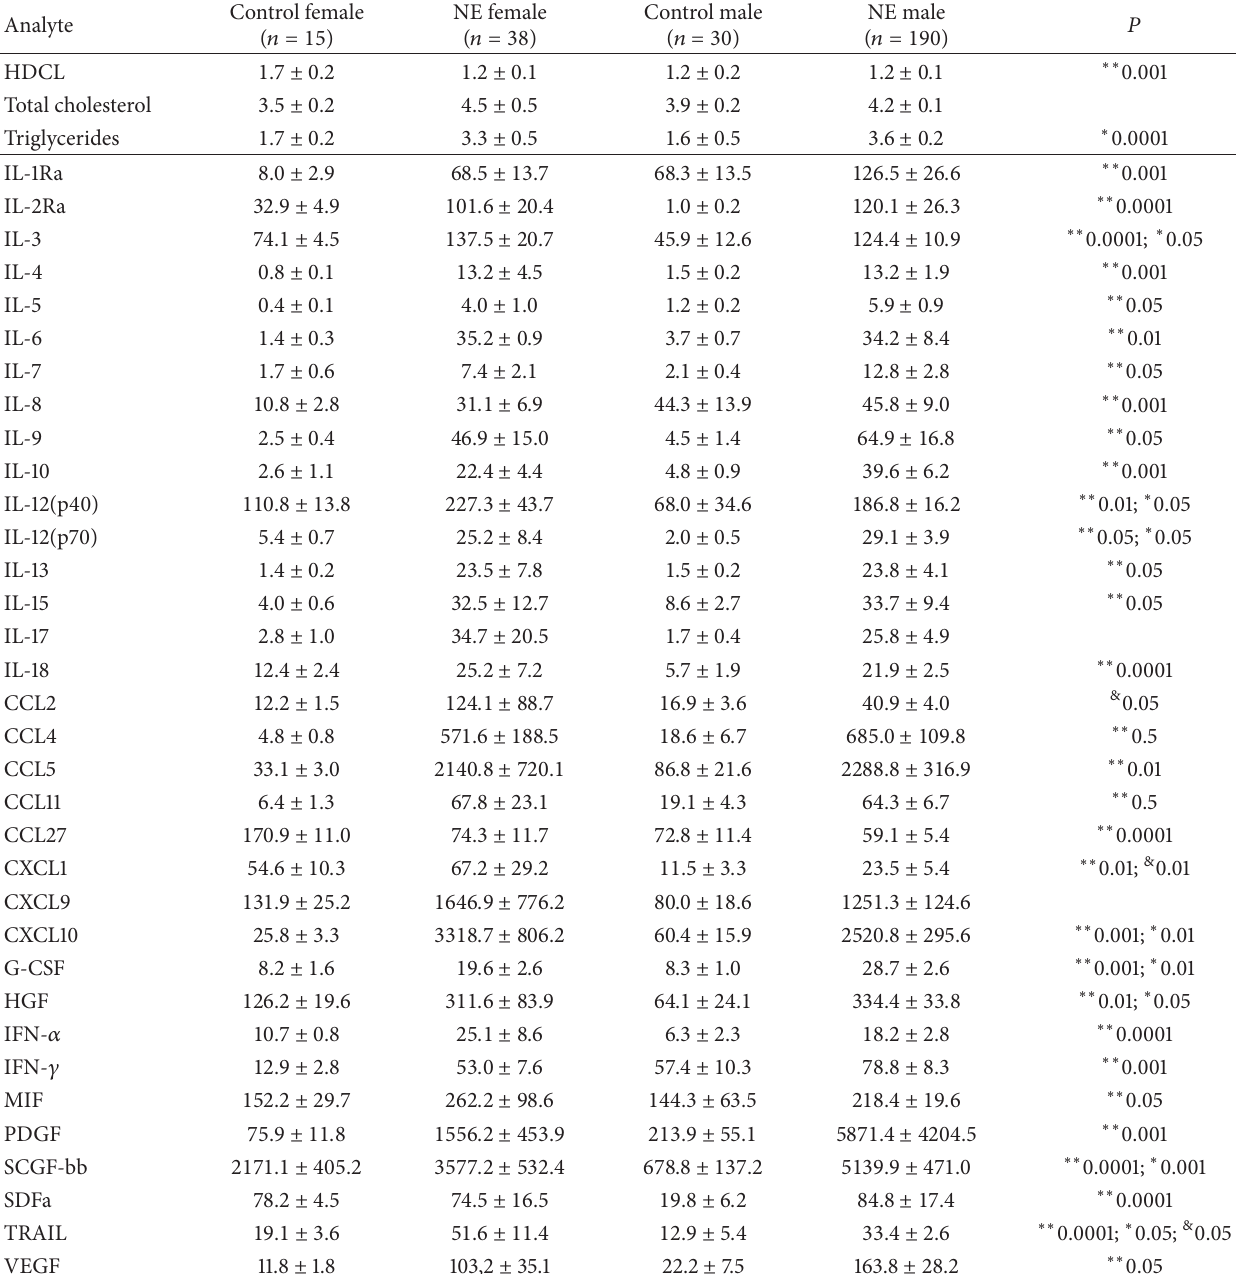
Table 4: Gender based lipid (mmol/L) and cytokine (pg/mL)